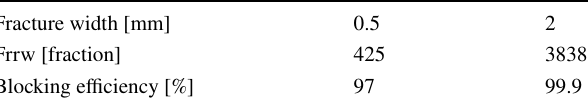
Table 5 Summary of Frrw and blocking efficiency for (1450 pa) gel strength Fracture width